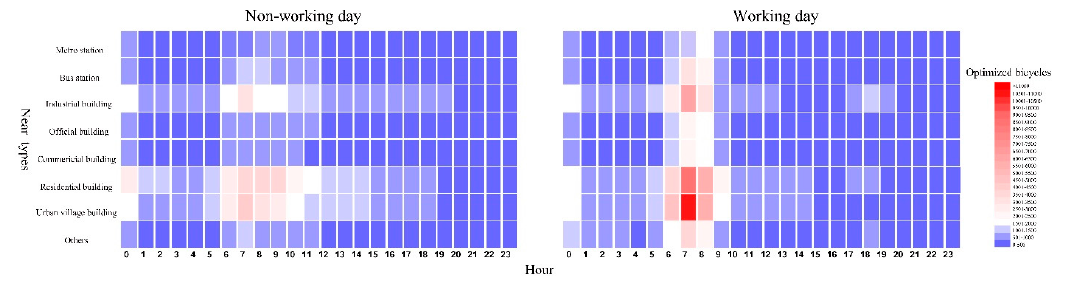
Figure 8. The nearby spatial and temporal characteristics of the first trip for all optimized bikes.